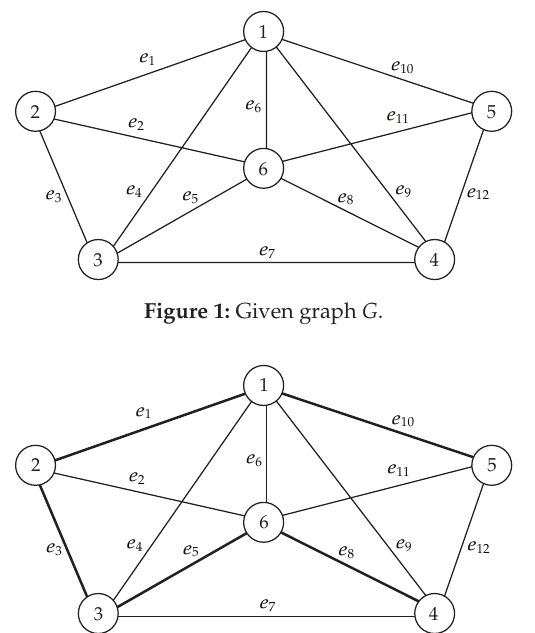
Figure 2: Optimal spanning tree of standard BST